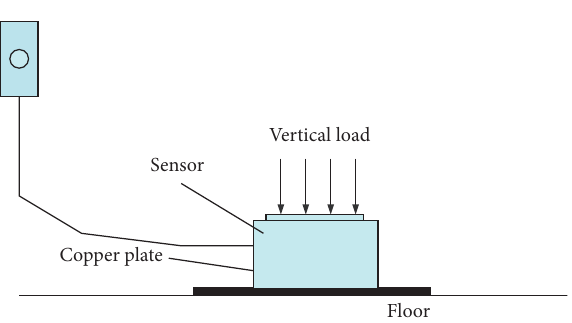
Figure 12: Layout of force monitoring sensor for filling